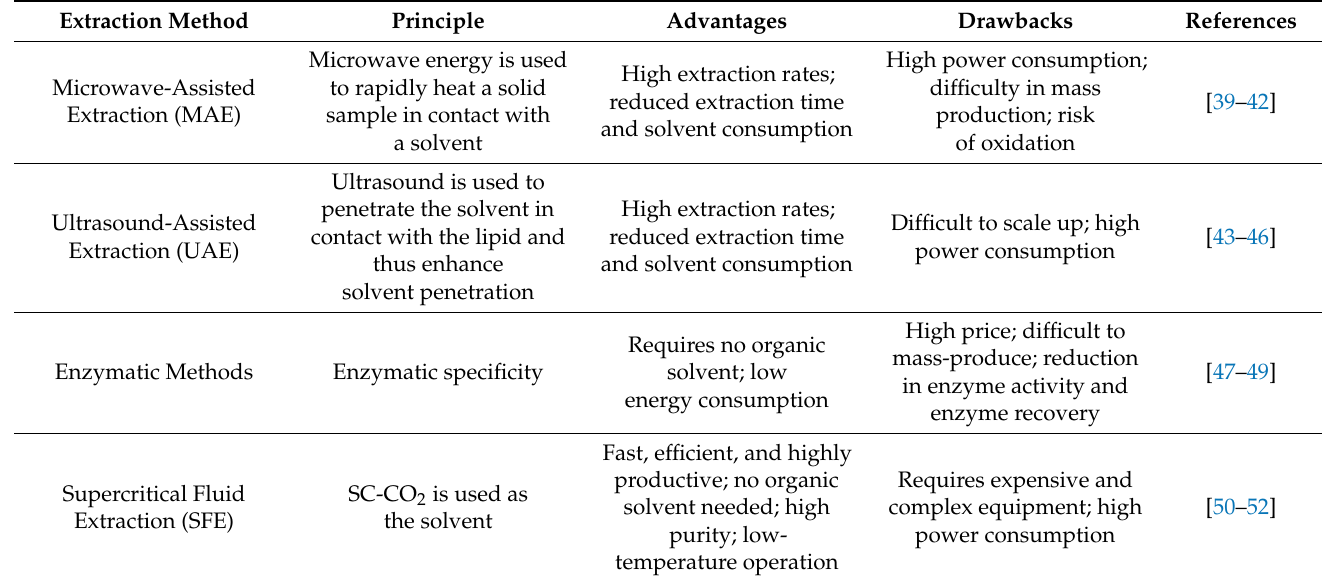
Table 3. Comparison of fish oil extraction